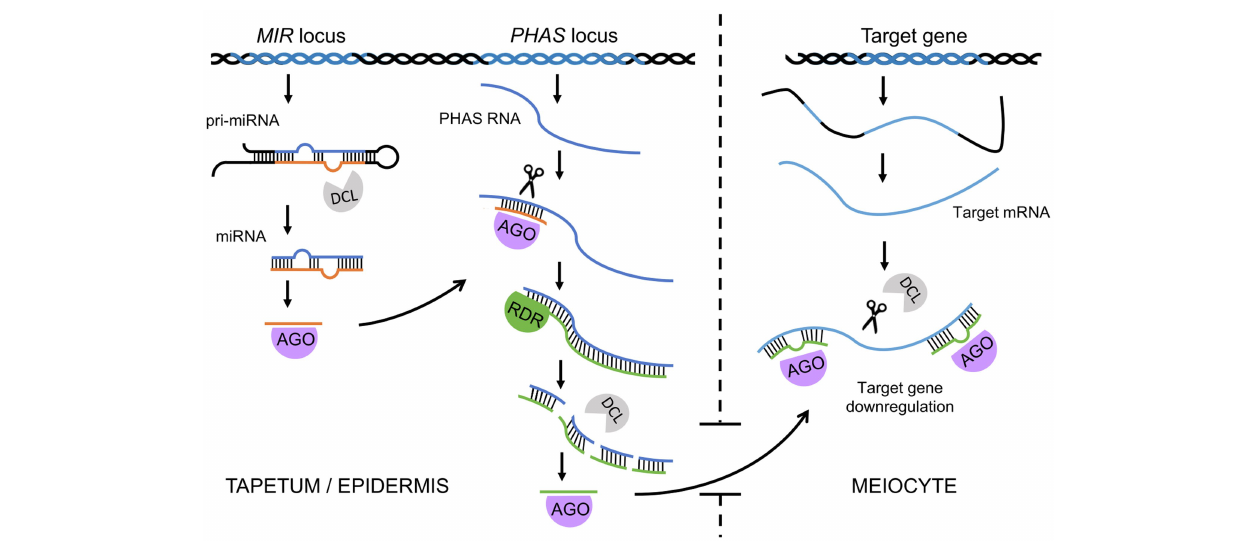
FIGURE 2 | A simplified model for phased small interfering RNA biogenesis and function in male meiosis in grasses. miRNAs are transcribed from MIR loci, and after processing by Dicer (DCL), one miRNA strand is loaded onto the AGO protein. The miRNA-AGO complex binds to a PHAS transcript based on sequence complementarity, cleaves it at the binding site, and triggers synthesis of the second strand. dsRNA is then sliced by DCL starting from the cleavage site in a phased manner. The resulting phasiRNAs are then loaded onto another AGO protein (e.g., MEL1) and transported from the tapetum (21-nt phasiRNAs) or epidermis (24-nt phasiRNAs) to meiocytes. Finally, the phasiRNA-AGO complexes bind target transcripts of genes or transposable elements and, with the help of DCL, trigger their